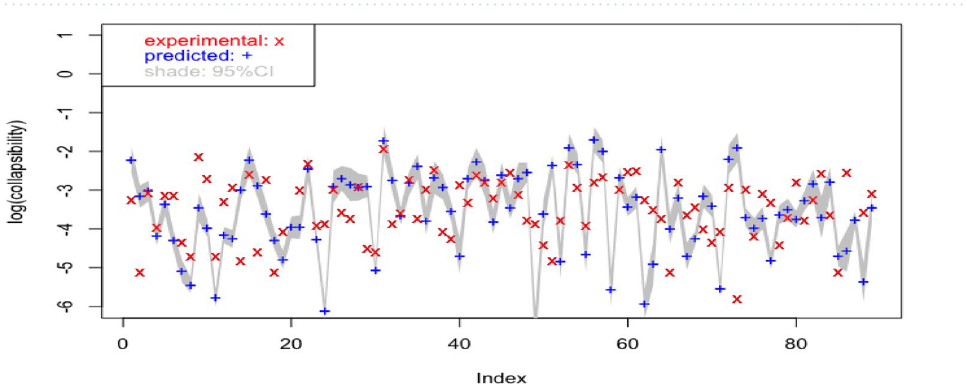
Figure 3. Predicted values with 95% confidence interval overlaid by observed values at log-scale: multiple linear model validated on samples from Lv